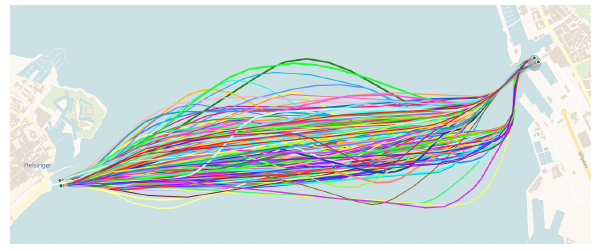
Figure 9 . Set of similar routes between two ports